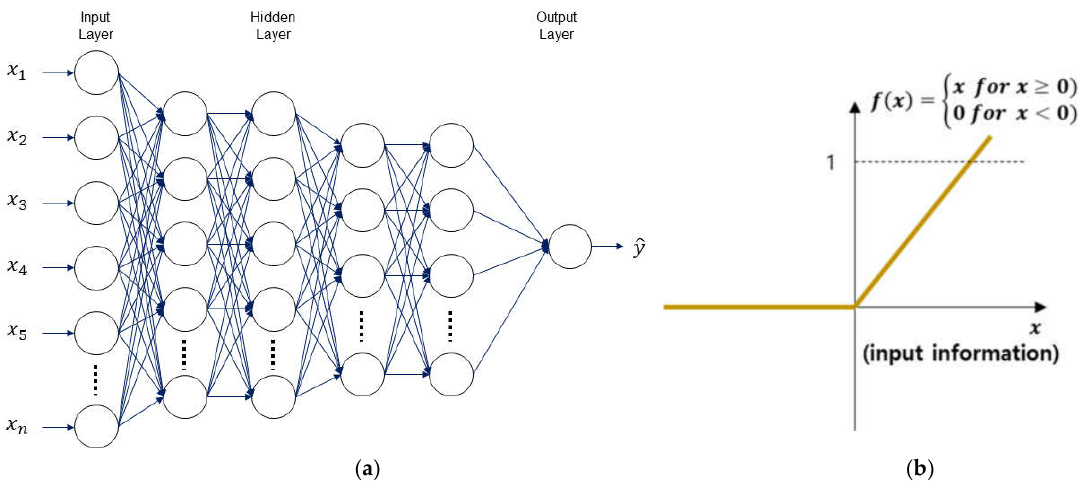
Figure 1. ( a ) Deep neural network (DNN) and ( b ) rectified linear units (ReLU) activation function.